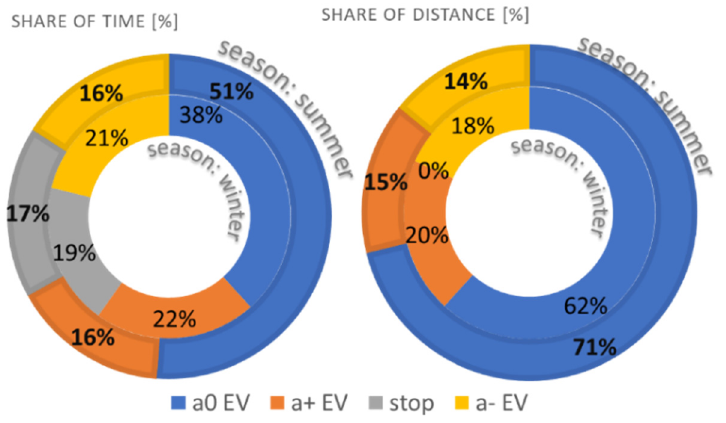
Figure 19. Comparison of the driving conditions (RDC) test for the performed test runs in winter and summer conditions.